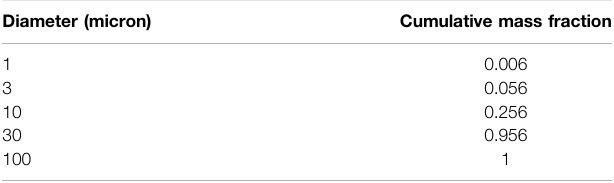
TABLE1| totalgrainsizedistributionassociatedwiththeeruptionofEyjafjallajökull (2010) between 5 – 8 May 2010, (Bonadonna et al. (2011)) Diameter (micron)